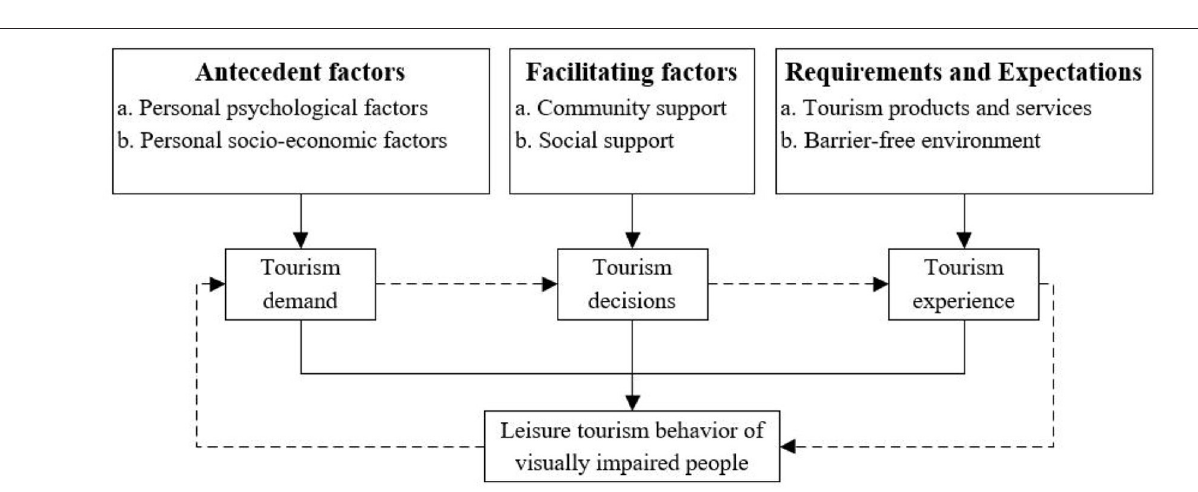
FIGURE 1 | Factors influencing the leisure tourism behavior of visually impaired individuals.